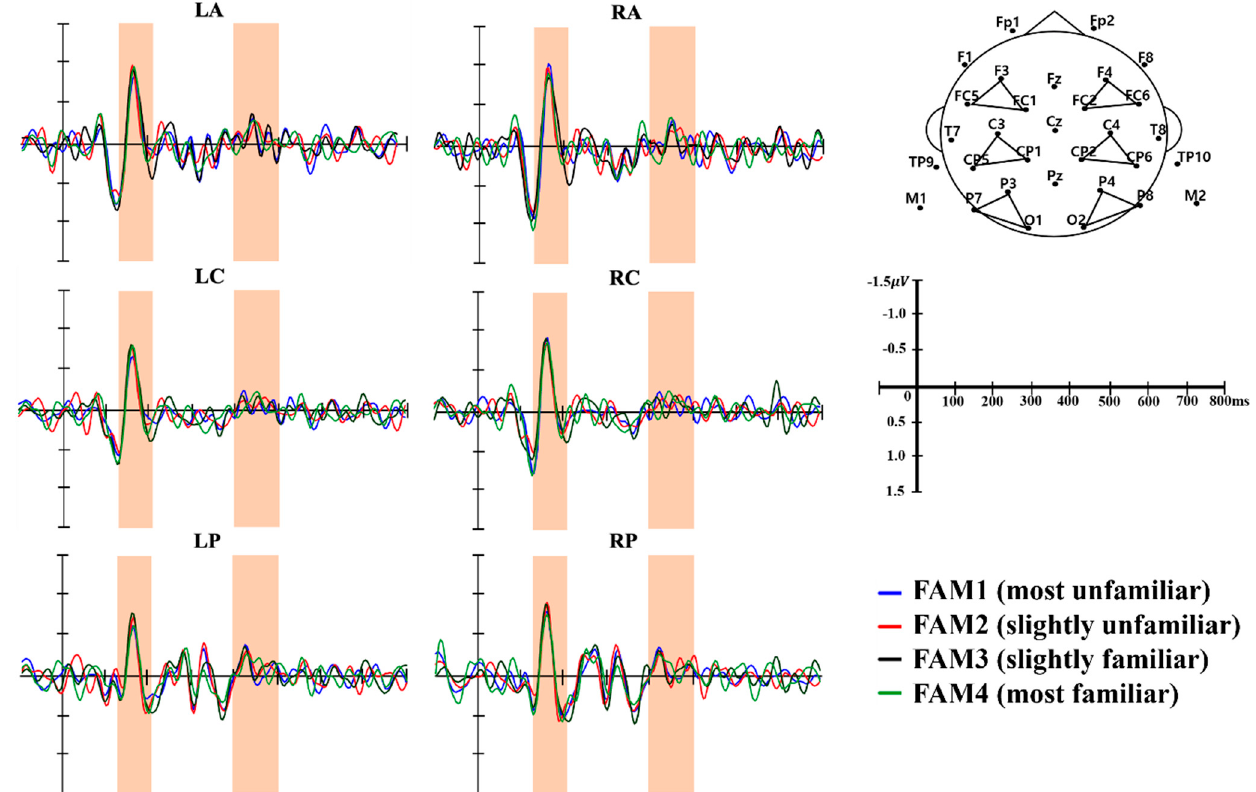
Figure 1. The grand-averaged event-related potentials (ERPs) in response to words of the four familiarity levels at 6 di ff erent electrode regions on the scalp. Each grand-averaged line is marked with a di ff erent color according to the familiarity level (FAM1 − blue line, FAM2 − red line, FAM3 − black line, and FAM4 − green line). The electrode regions were selected as LA (F3, FC1, and FC5), LC (C3, CP1, and CP5), LP (P3, P7, and O1), RA (F1, FC2, and FC6), RC (C4, CP2, and CP6), and RP (P4, P8, and O2). The shaded region in the time window of N100 (130–210 ms) and N400 (400–500 ms) indicates the asymmetric familiarity e ff ect across the two hemispheres ( p < 0.05, FDR corrected). Abbreviations: LA (left anterior), LC (left central), LP (left posterior), RA (right anterior), RC (right central), RP (right posterior), FAM1 (most unfamiliar), FAM2 (slight unfamiliar), FAM3 (slight familiar), and FAM4 (most familiar).